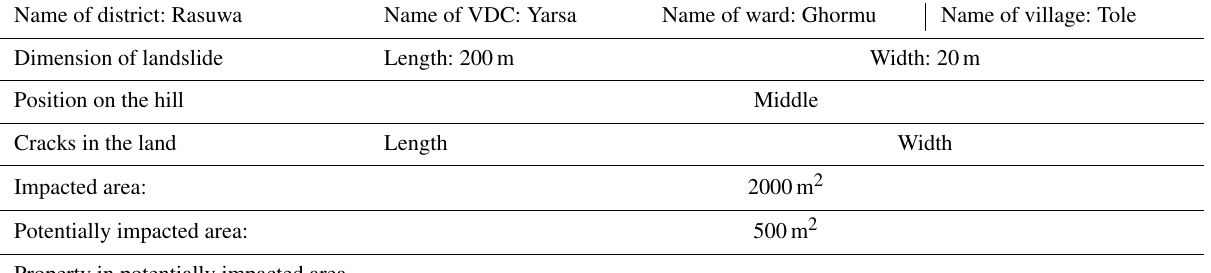
Table 2. Example of a landslide-mapping information sheet (DSCWM, 2016). VDC: village development committee. Ropani: unit of mea- surement equal to 94.05m 2 (https://www.ksmnepal.com/Post-Details/post/143/land-measurement-in-nepal, last access: 15 December